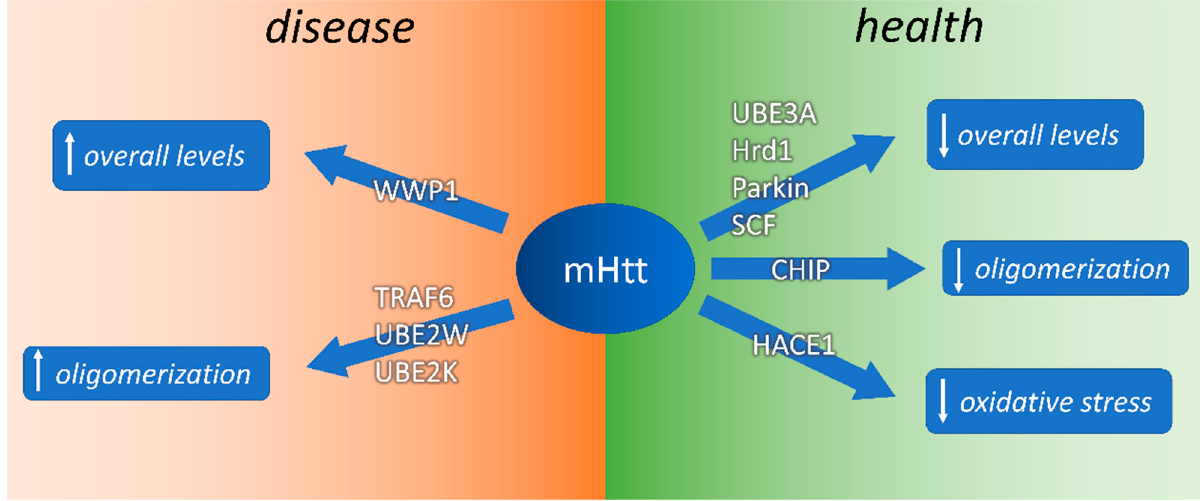
Figure 7 . Ubiquitin–proteasome system enzymes involved in mHtt ubiquitination and polyubiquitination and their effects on HD pathology.